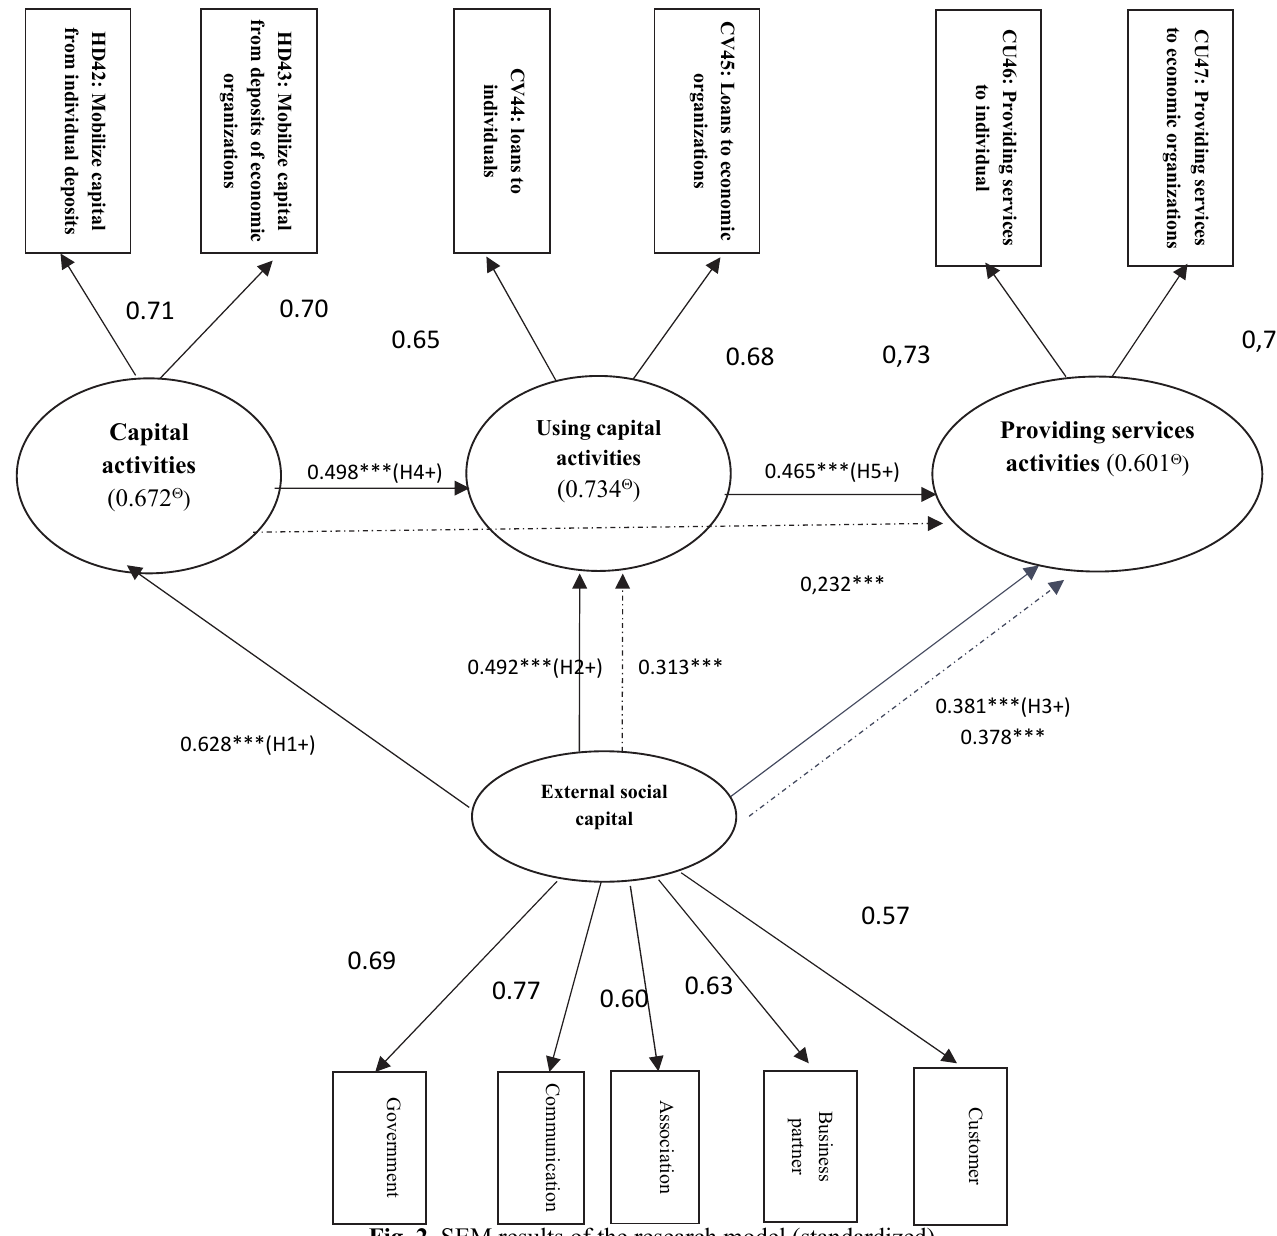
Fig . 2 . SEM results of the research model